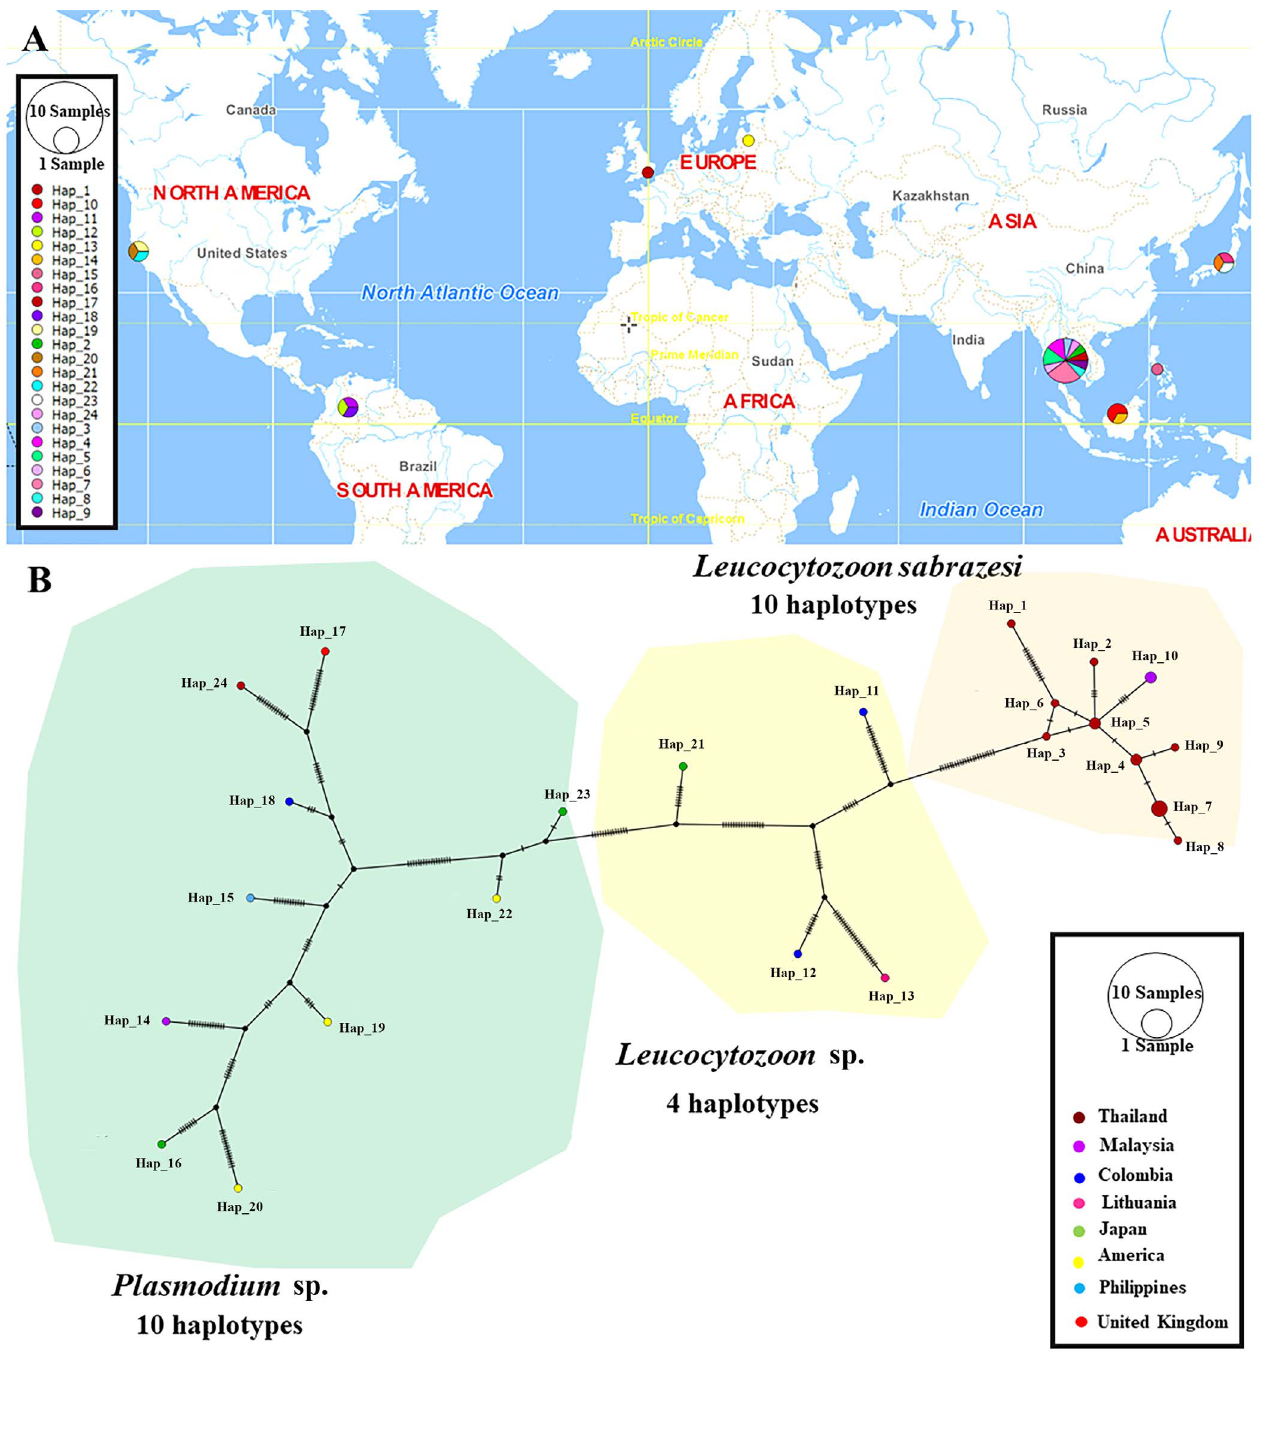
Fig. 9. TCS network of haplotypes based on Leucocytozoon spp. and Plasmodium spp. coxIII gene sequences (A) detected in Thailand and other countries. The number of bars on lines between a haplotype and another represent the number of nucleotide mutation